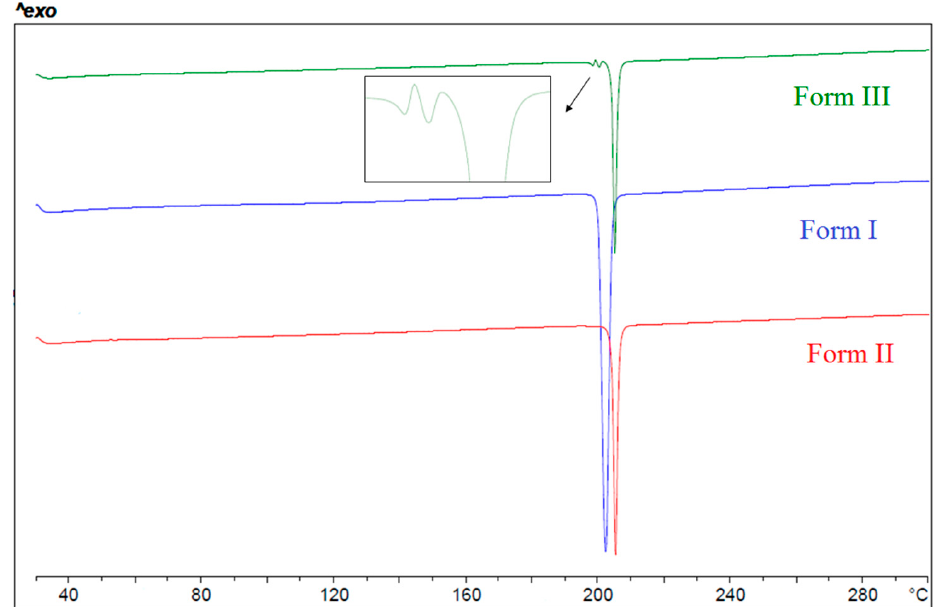
Figure 2. DSC analysis of the different anhydrous forms of BL, showing the melting of form I at 200 °C, form II at 202 °C and form III at 197 °C followed by simultaneous crystallization and melting of form I and subsequent crystallization and melting of form II.